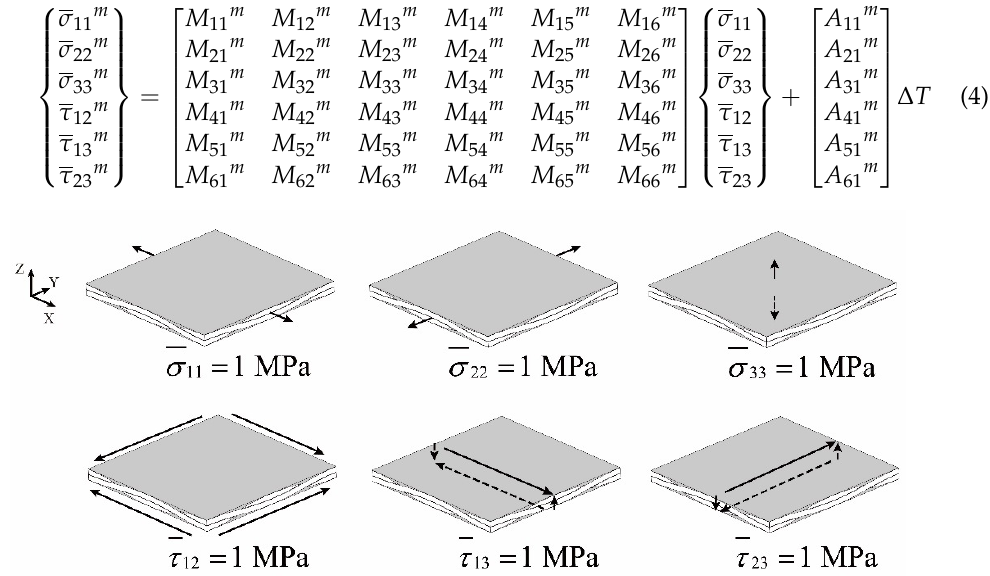
Figure 21. Unit stresses applied on the meso-scale FE model in obtaining the meso-scale stress amplification factors.